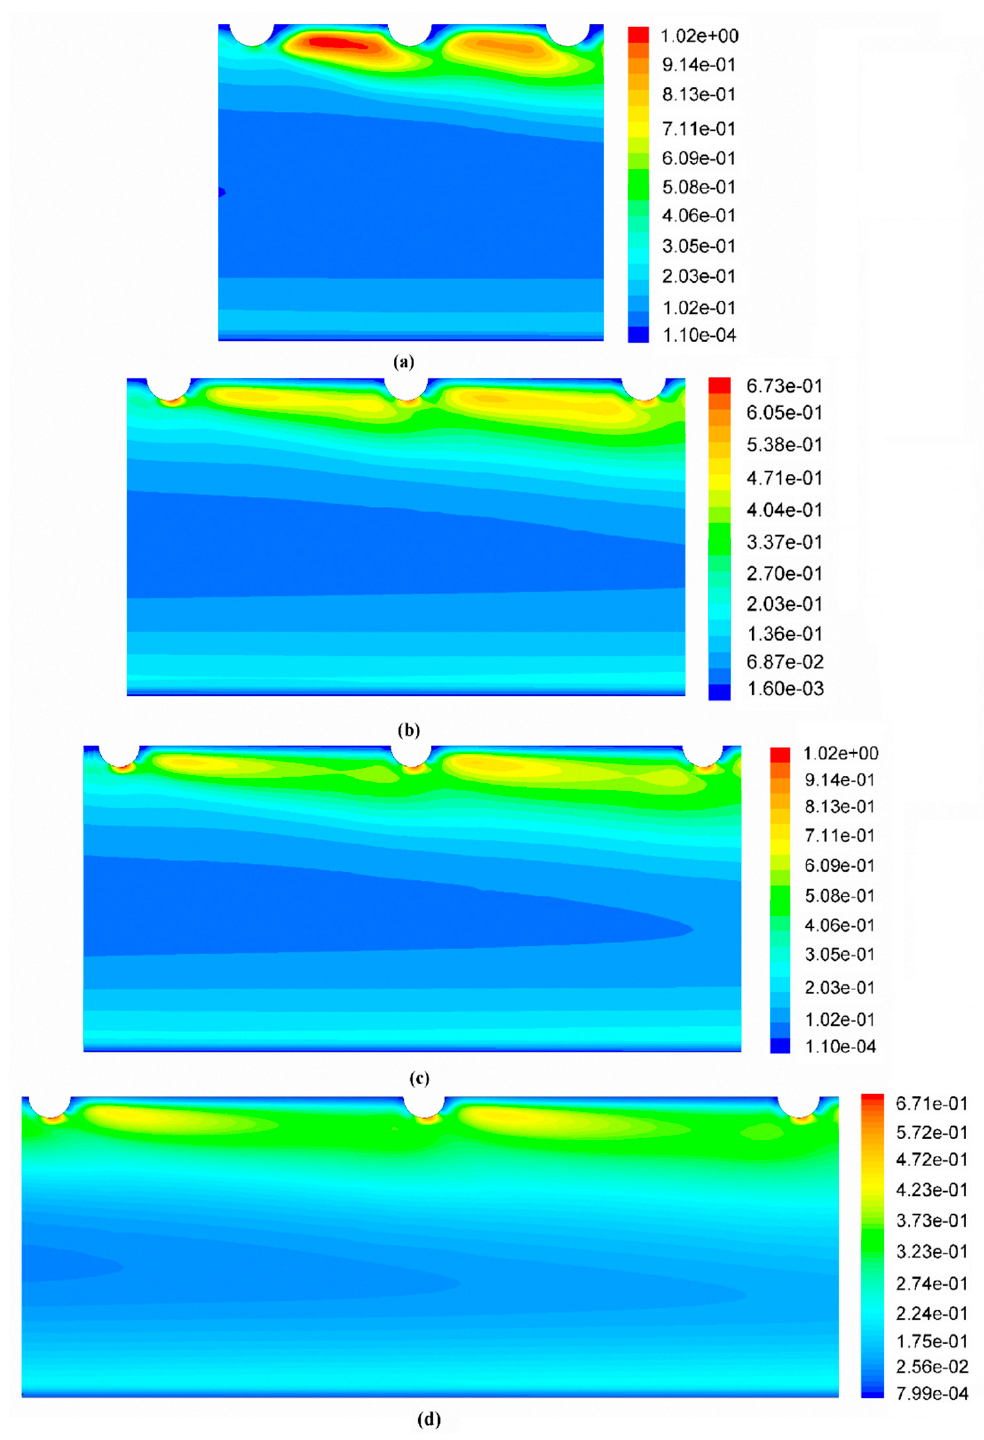
Figure 7. A contour plot of TKE for RRH = 0.045 at Re = 8000 for: ( a ) RRP = 6.67, ( b ) RRP = 10, ( c ) RRP = 13.33 and ( d ) RRP = 16.67.